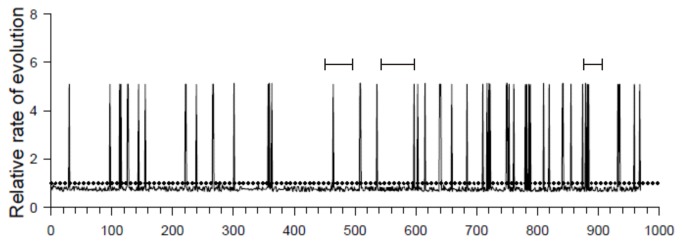
Relative rate of evolution of the UL32 gene based on amino acid-sequence.The mean evolutionary rate per amino acid site within the UL32 gene was calculated to identify genomic regions with a more than average genomic variation. Relative evolutionary rates are shown for each site next to the site number. These rates are scaled such that the average evolutionary rate across all sites is 1 (dotted line). This means that sites showing a rate < 1 are evolving slower than average and those with a rate > 1 are evolving faster than average. These relative rates were estimated with the use of MEGA under the Jones-Taylor-Thornton model (+G) (21). Known immunogenic epitopes are indicated by horizontal bars above the graph [28-30].